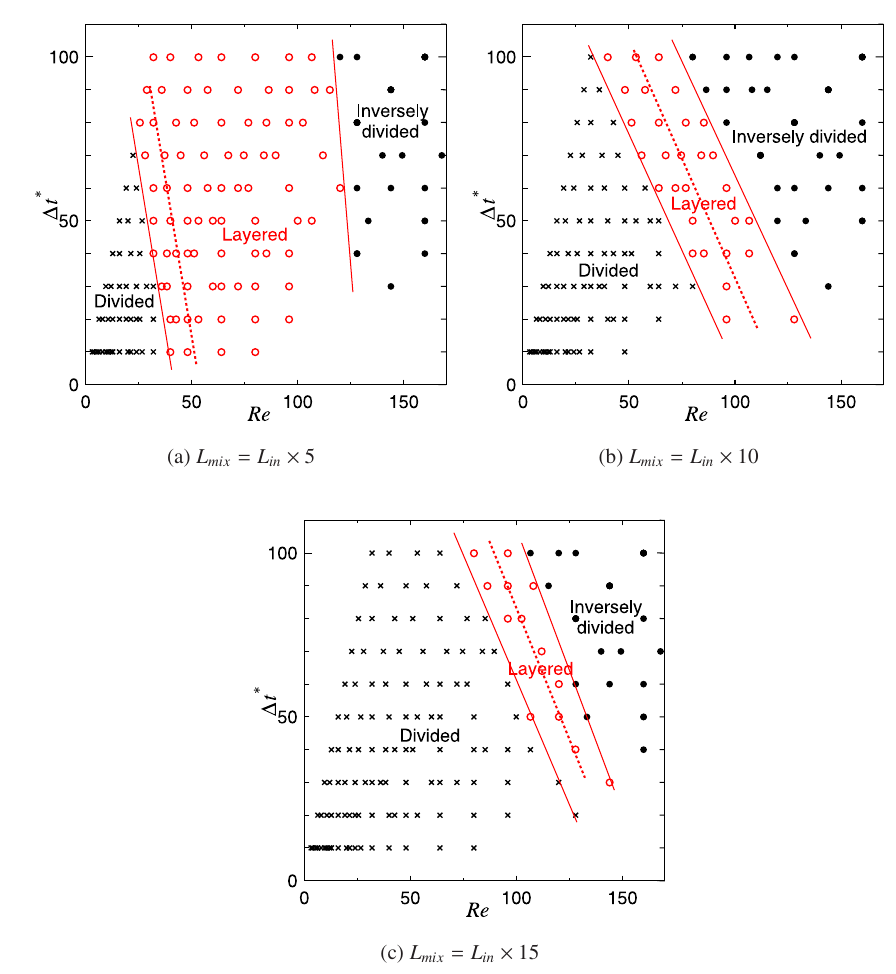
Fig. 7 Flow pattern maps for cross-shaped channels ( θ = 0) having di ff erent mixing channel width. The dotted lines indicate the condition for symmetric layered